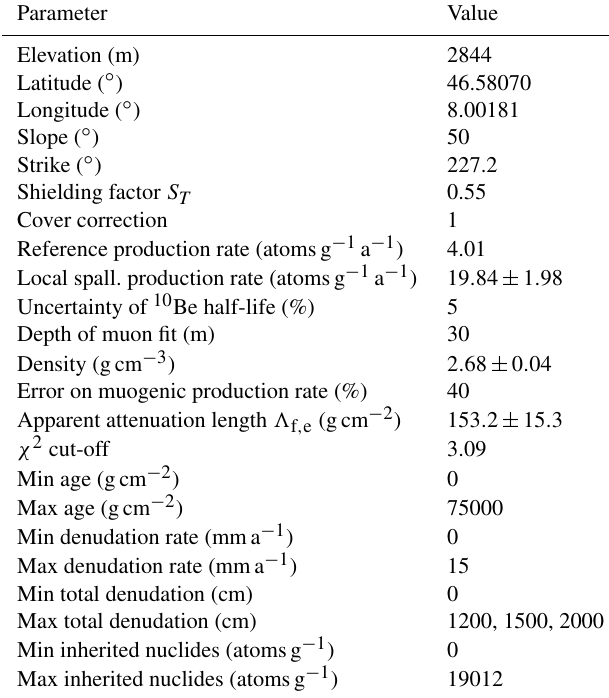
Table A2. Input parameters for the modified Monte Carlo (MC) simulation code of Hidy et al. (2010).